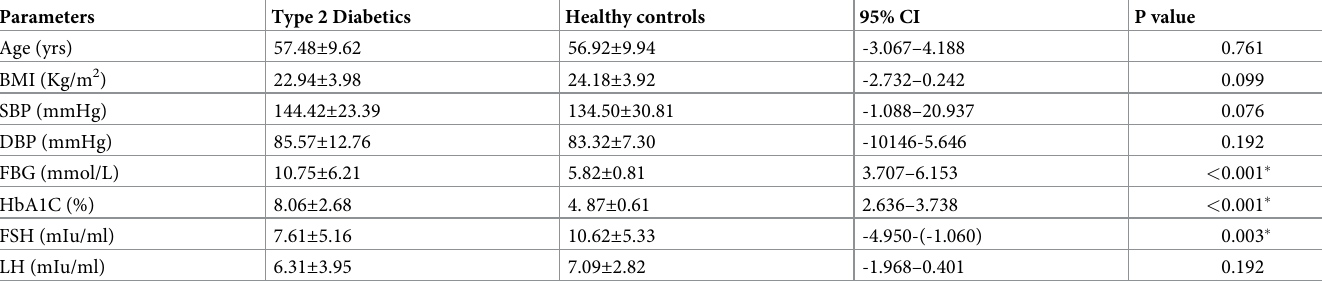
Table 3. Clinical and hormonal parameters of type 2 diabetic and healthy hypogonadal men. Parameters Type 2 Diabetics Healthy